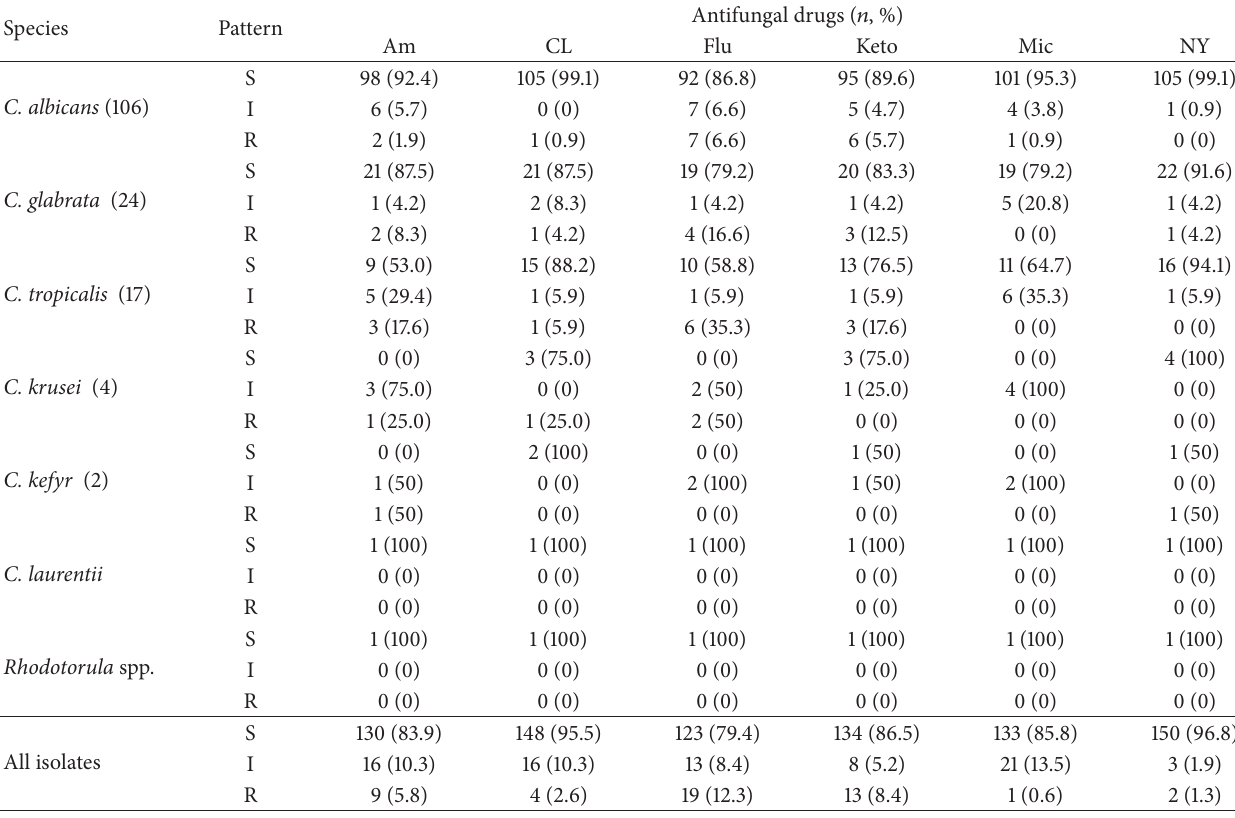
Table 5: In vitro antifungal susceptibility pattern of yeast